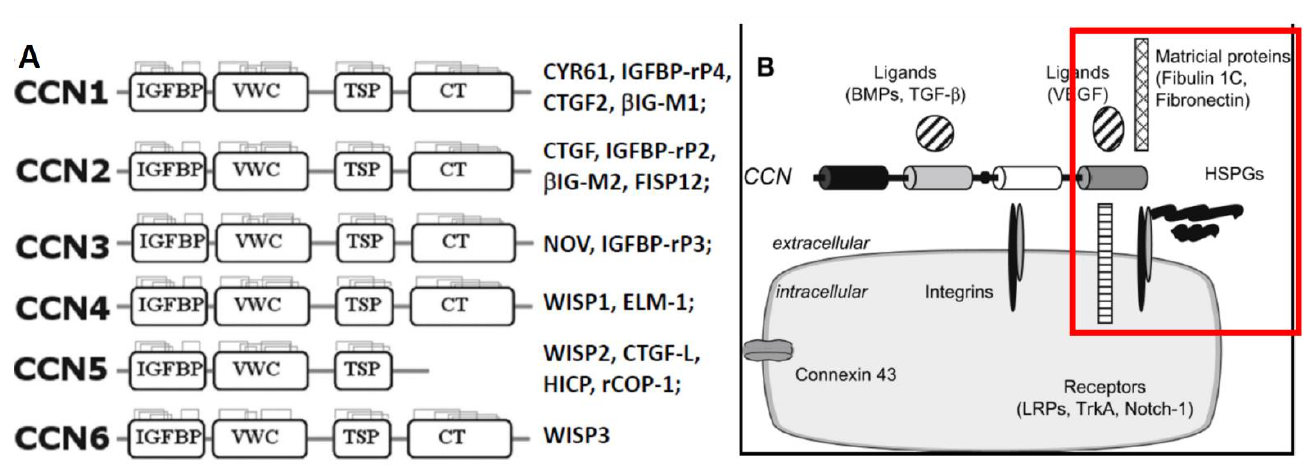
Figure 1. Schematic representation of the CCN/WISP family and partners. ( A ) The domain structure and other names given to different family members. ( B ) CCN proteins are known to interact with a broad range of partners: integrins; ECM components including heparin-sulfated proteoglycans (HSPGs), fibronectin, and fibulin 1C; receptors including low-density lipoprotein receptor-related proteins (LRPs), Notch1, TrkA, and other factors such as bone morphogenic proteins (BMPs), transforming growth factor (TGF)-β, vascular endothelial growth factor (VEGF), S100A4, and connexin 43. The red square indicates what would be missing for the interactions with CCN5 when it lacks the CT domain. Adapted from [7,8,16].